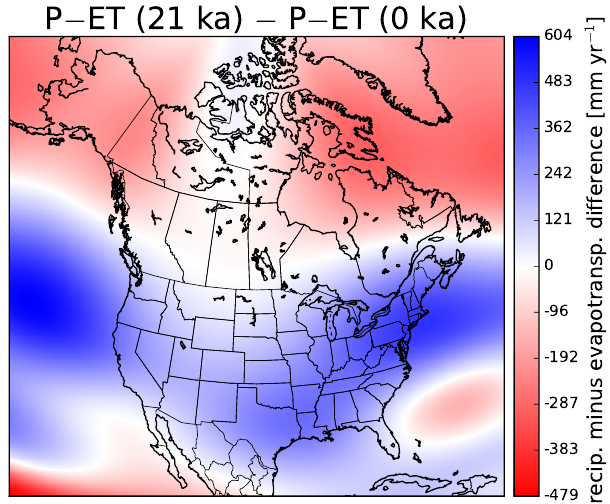
Figure 3. Modeled changes precipitation minus evapotranspiration between the LGM and present. Modeled changes precipitation mi- nus evapotranspiration between the LGM and present. These dif- ferences were calculated with the TraCE-21K continuous LGM to present paleoclimate run (Liu et al., 2009; He, 2011) of the CCSM3 GCM (Collins et al., 2006). They are combined with ice mass bal- ance to produce water inputs for computed